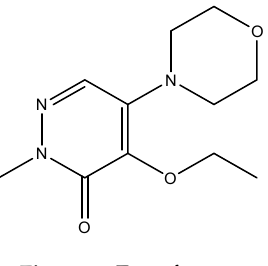
Figure 1. Emorfazone. Figure 1.